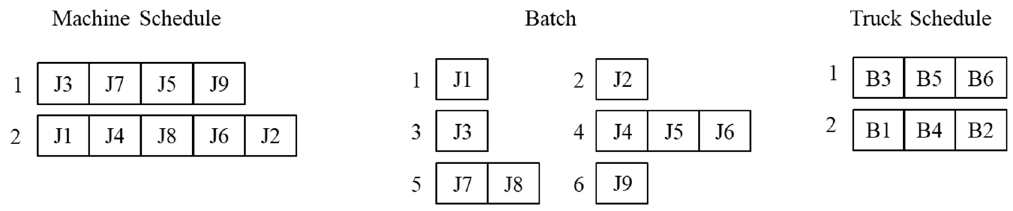
Figure 2. A solution representation for the integrated scheduling problem.